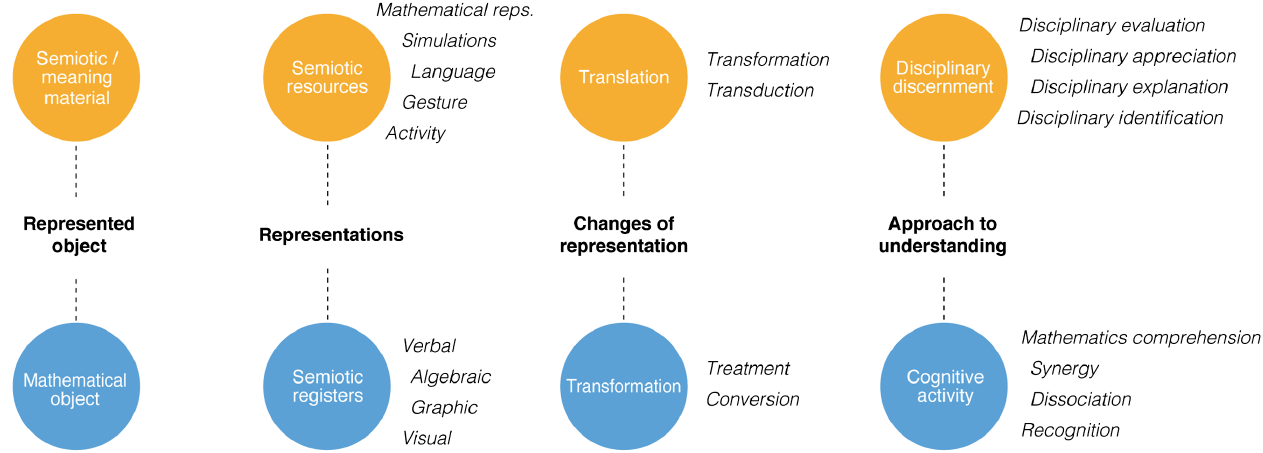
FIG. 5. Different areas that could be analyzed. With the social semiotics approach on the yellow side and the theory of representations of semiotic registers on the blue side. Image created by Dr. Elias Euler for this